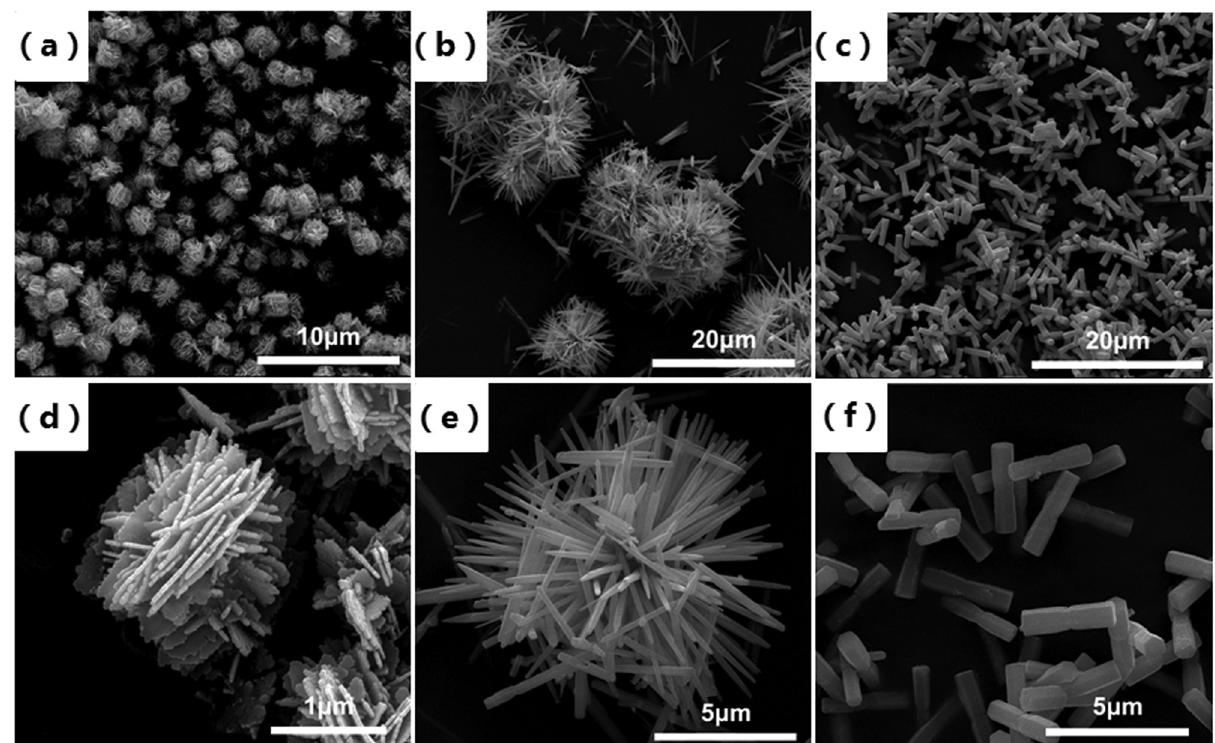
Figure 4: SEM images of ( a and d ) fl ower - like ZnO, ( b and e ) sea urchin ZnO, and ( c and f ) rod - like